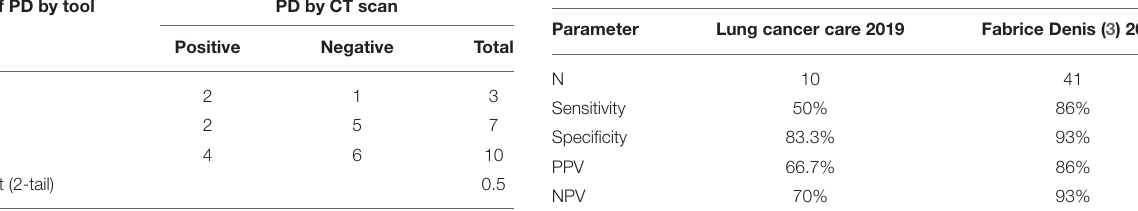
TABLE 4 | Comparison of tool performances for detecting disease progression between Lung Cancer Care application and previous patient-reported outcome (PRO) international